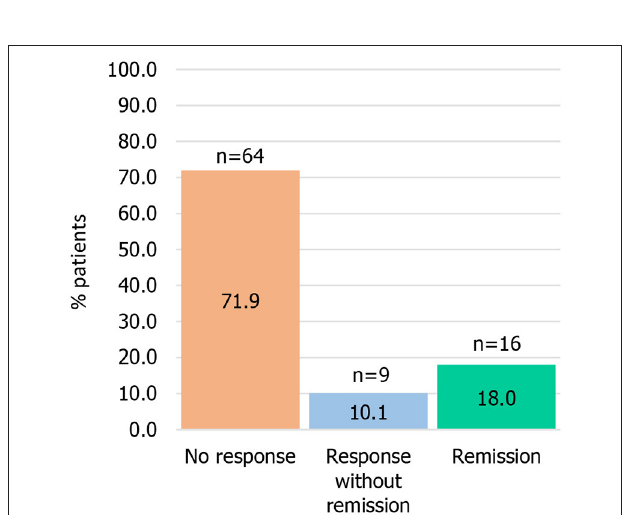
FIGURE 2 | Treatment response* among patients with treatment-resistant depression at 6 months. *Remission: Montgomery-Åsberg Depression Rating Scale (MADRS) score ≤ 10; response (without remission): ≥ 50% improvement in the MADRS score, with MADRS > 10.